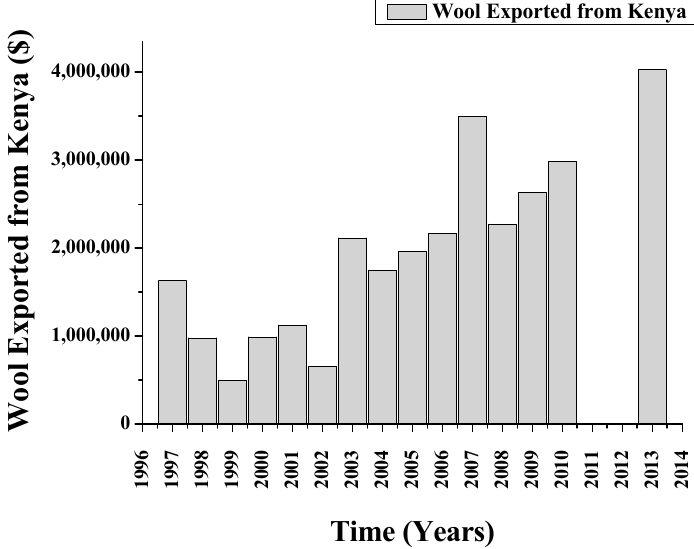
Figure 3. Wool exports from Kenya over the past years.